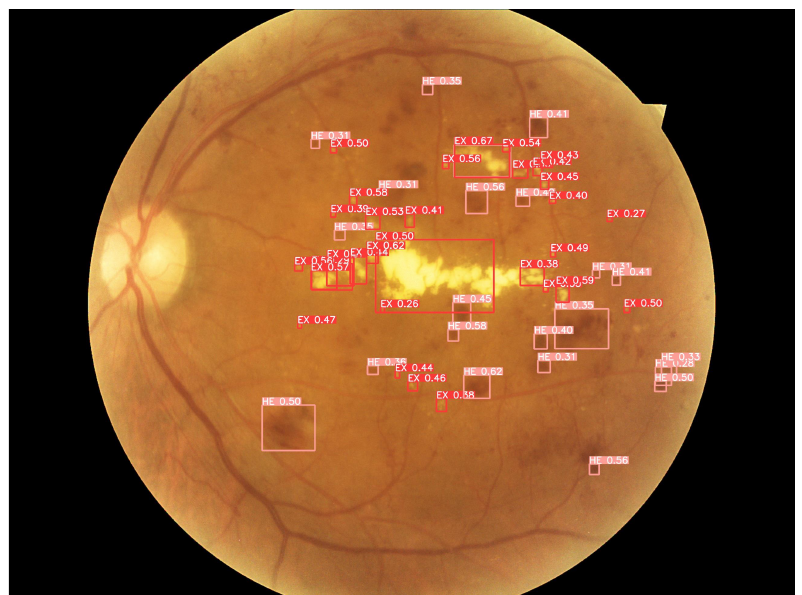
Figure 13. Detection of fundus lesions in the “007-3892-200.jpg” image of the test set of the Dataset for Diabetic Retinopathy (DDR). It is possible to observe different morphological aspects of the identified lesions, as in the case of hard exudates in the image’s central region and distributed in other regions of the retina, or hemorrhages, which, like the hard exudates detected. Also, they assume different shapes and sizes, in addition to being able to manifest themselves in different regions of the